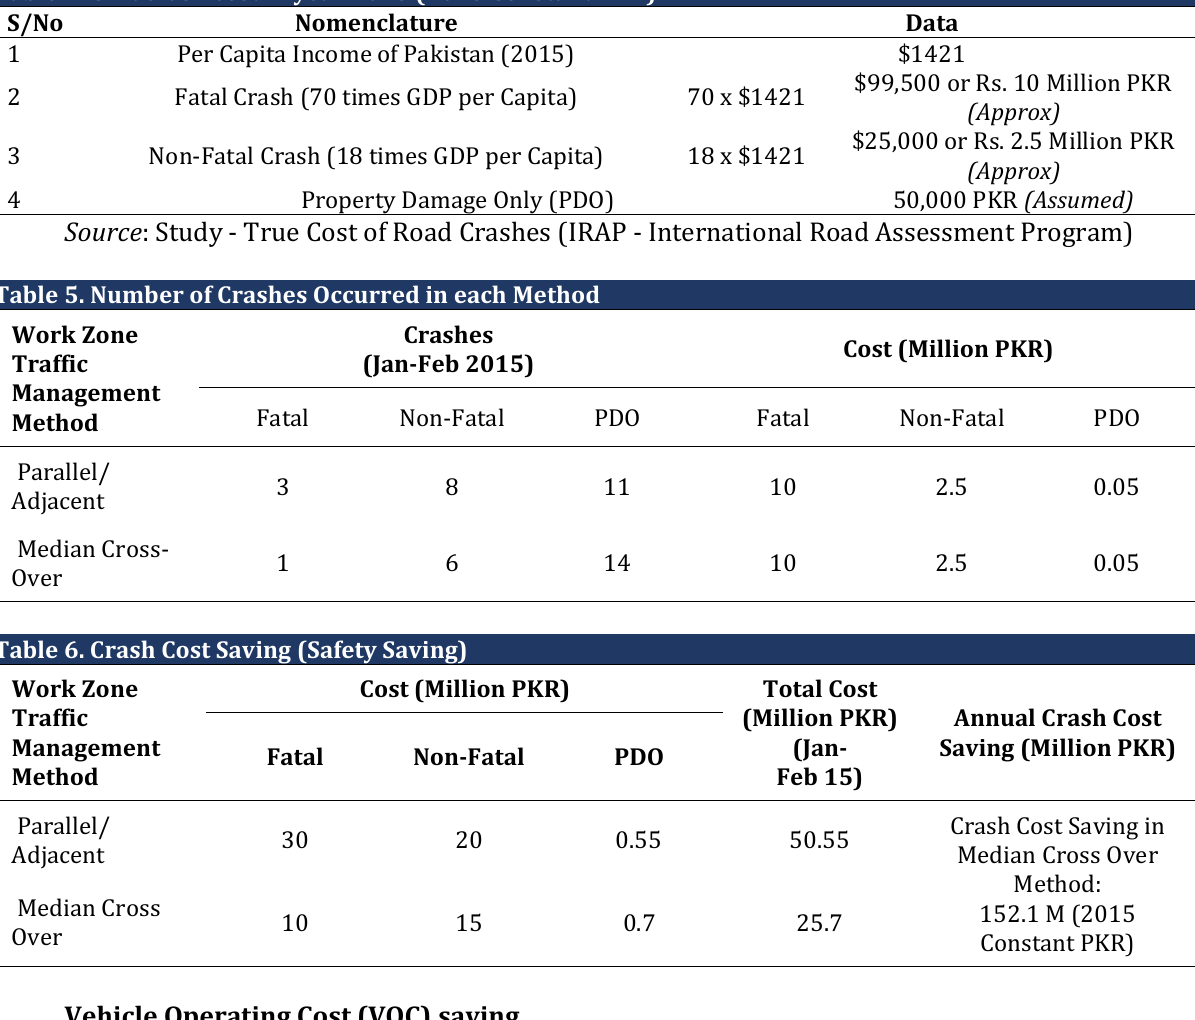
Table 4. Unit crash cost in year 2015 (2015 Constant PKR)